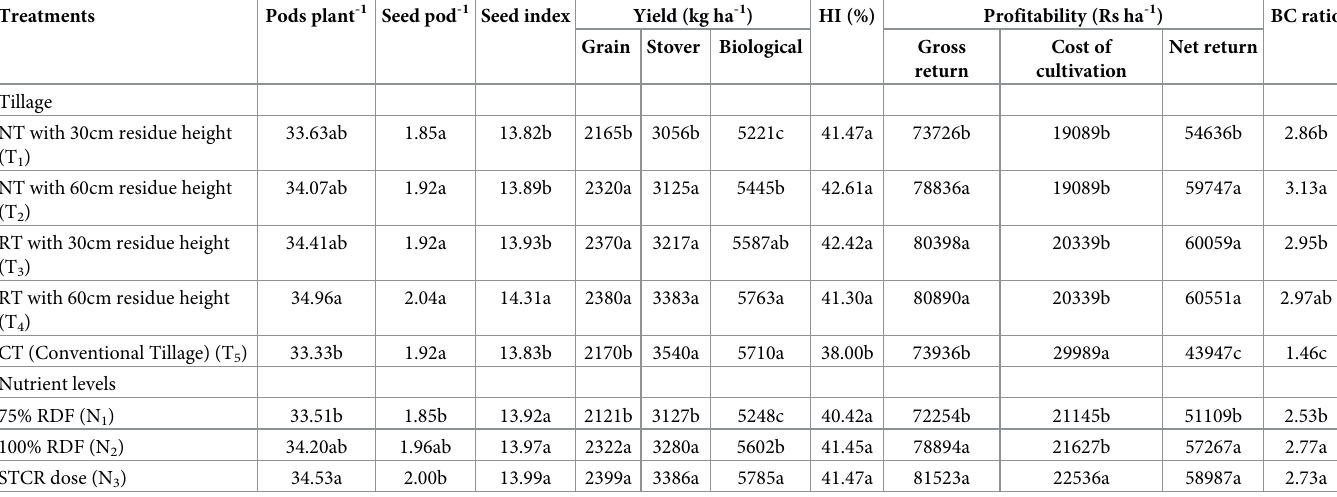
Table 3. Effect of tillage practices, crop residue management and nutrient levels on yield attributes, yield and economics of chickpea.